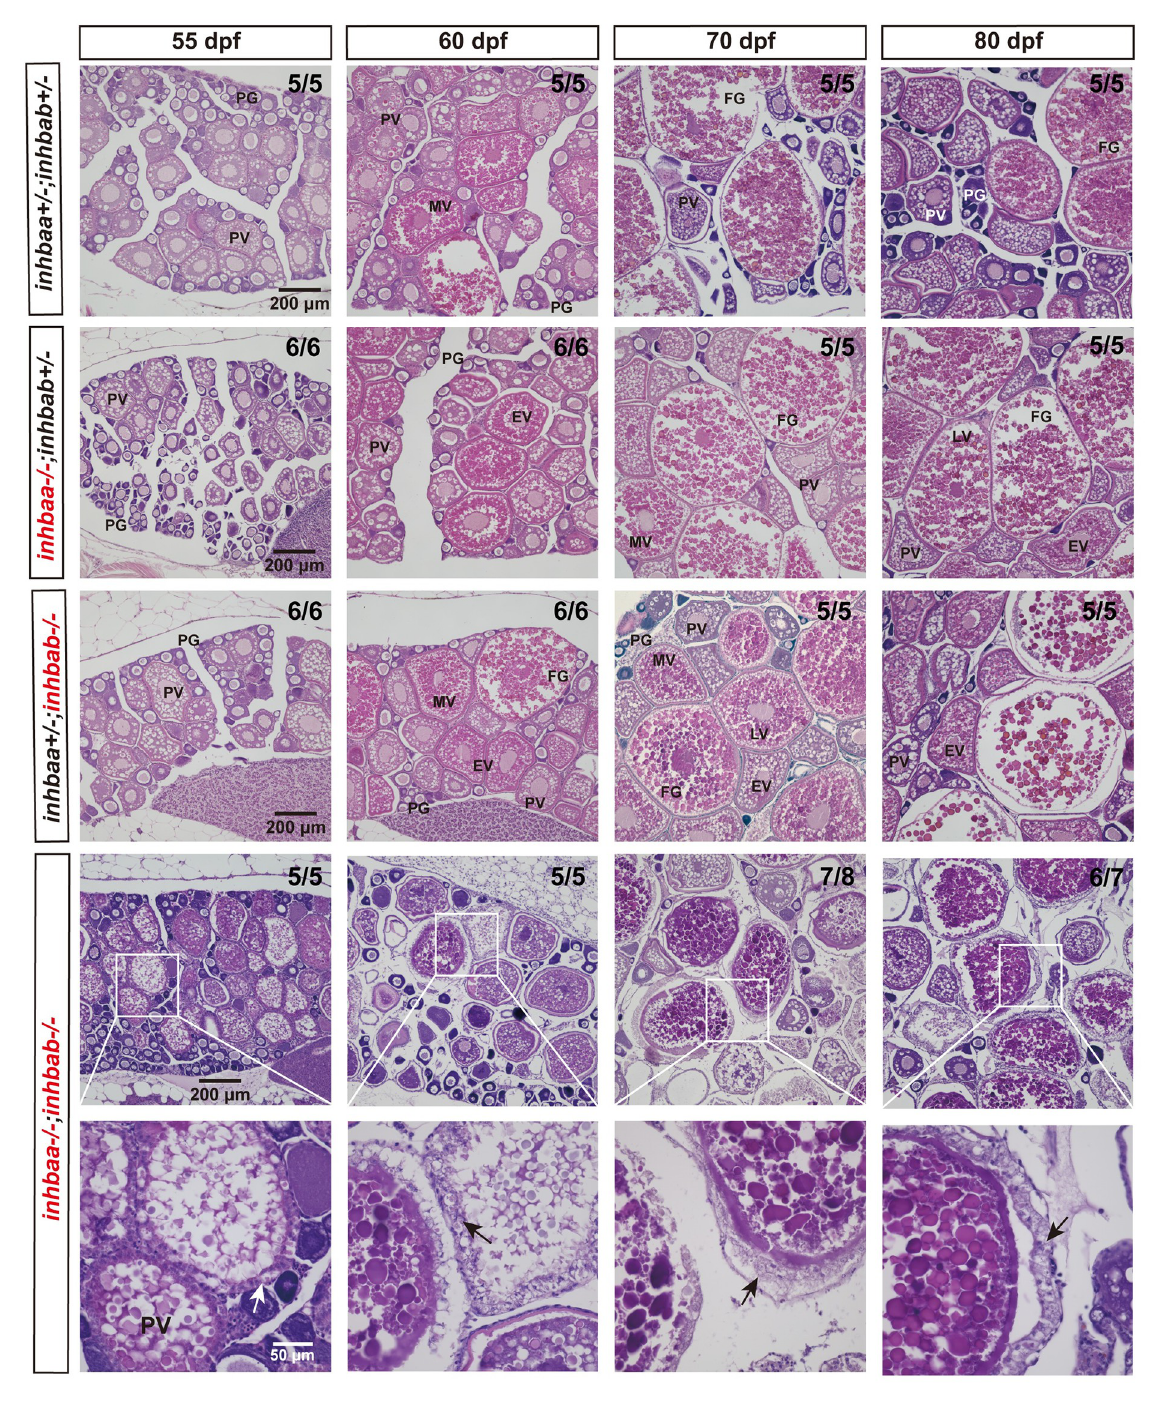
Fig 5. Histological analysis of activin β A mutant females during post-pubertal maturation (55–80 dpf). Follicles from control and β A single mutants ( inhbaa-/- , inhbab-/- ) showed normal growth and development. In the double mutant ( inhbaa -/-; inhbab -/-), abnormal follicles with hypertrophic granulosa cells could often be observed (arrow). The boxed areas are shown at higher magnification below. The numbers shown in the photos indicate the total number of fish examined (lower) and the fish exhibiting similar phenotype to that shown (upper). PG, primary growth; PV, previtellogenic; EV, early vitellogenic; MV, mid-vitellogenic; LV, late vitellogenic; FG, full-grown.